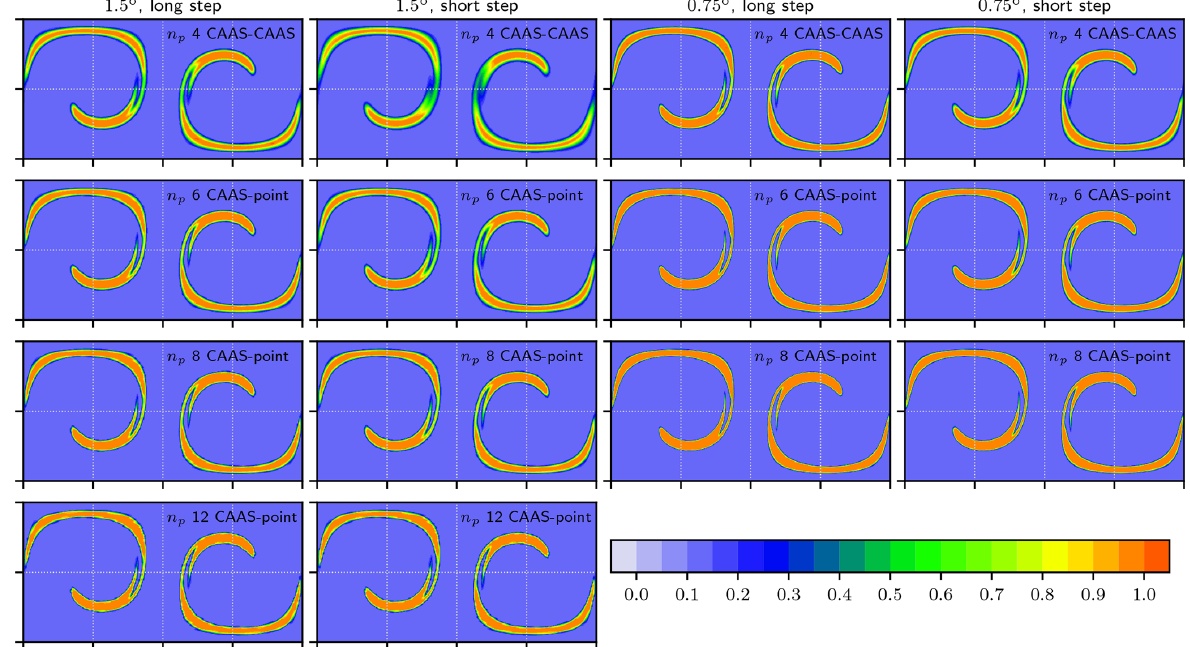
Figure 13. Images of the slotted cylinders IC advected by the non-divergent flow at the simulation’s midpoint. Each column corresponds to a spatial resolution and time step length configuration, as stated at the top of each column. Each row corresponds to a particular value of n t p , as stated in the text at the top right of each image. We omit n t p = 12 results for the 0 . 75 ◦ resolution because they are essentially identical at the resolution of the figure to the n t p = 8 images.